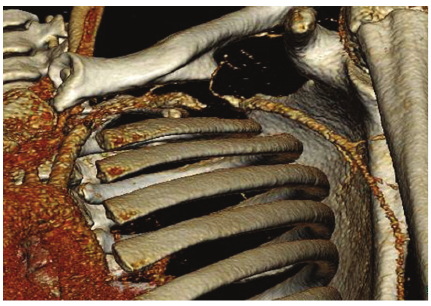
Figure 3: 3D reconstruction showing filling defect and pseudoa- neurysms in the left subclavian